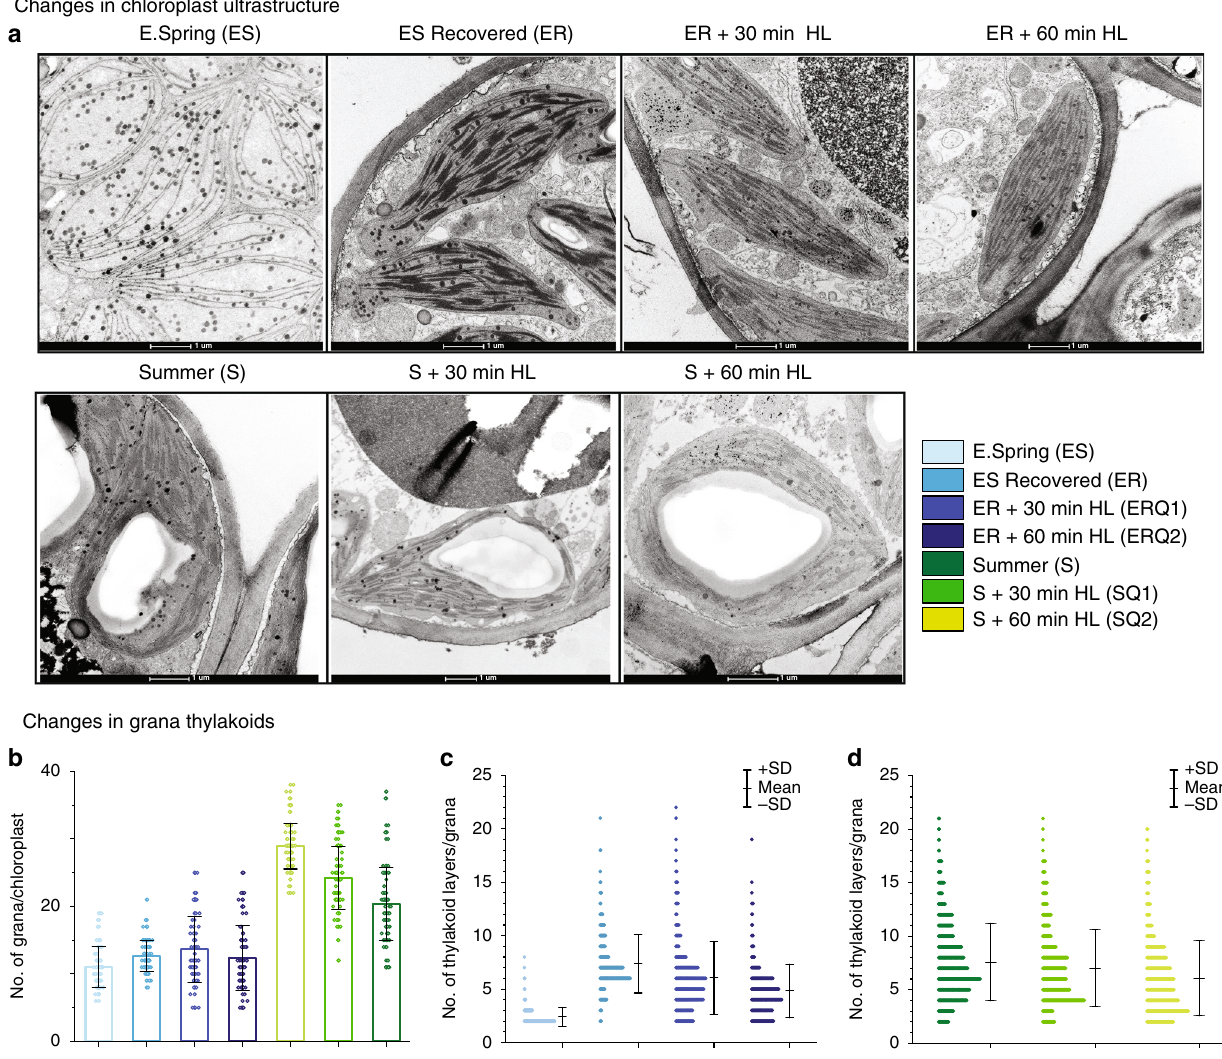
Fig. 5 Arti fi cial induction of changes in chloroplast ultrastructure of pine needles. a Changes in chloroplast ultrastructure in E. spring (ES), E. spring samples recovered (ER) at 18 o C for 48 h with a photoperiod of 18 h at 80 µ mol m − 2 s − 1 , ER samples treated with 800 µ mol m − 2 s − 1 high light for 30 min (ERQ1), for 60 min (ERQ2). Summer (S), Summer samples treated with 1200 µ mol m − 2 s − 1 high light for 30 min (SQ1), for 60 min (SQ2). b The number of grana per chloroplasts (Error bars indicate mean ± SD ( n = 75); c Histograms of frequency distributions of numbers of thylakoids per granum in different E. spring treated [ n = 220 (ES), 250 (ER), 272 (ERQ1), 246 (ERQ2)]. d Summer treated [ n = 576 (S), 498 (SQ1), 415 (SQ2)] samples. Error bars indicate the mean ± SD obtained from the analysis of grana